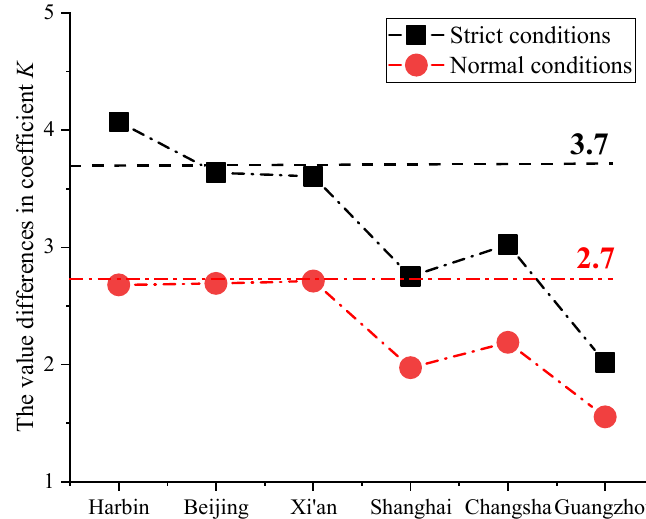
Figure 4. Relationship between the annual average values and the design concentration of PM 2.5 .